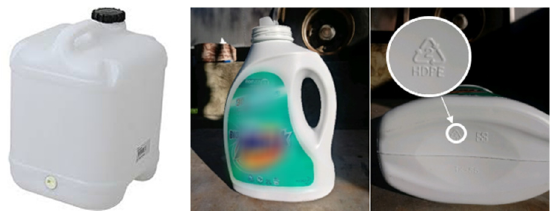
Figure 1. Used HDPE Polymer.